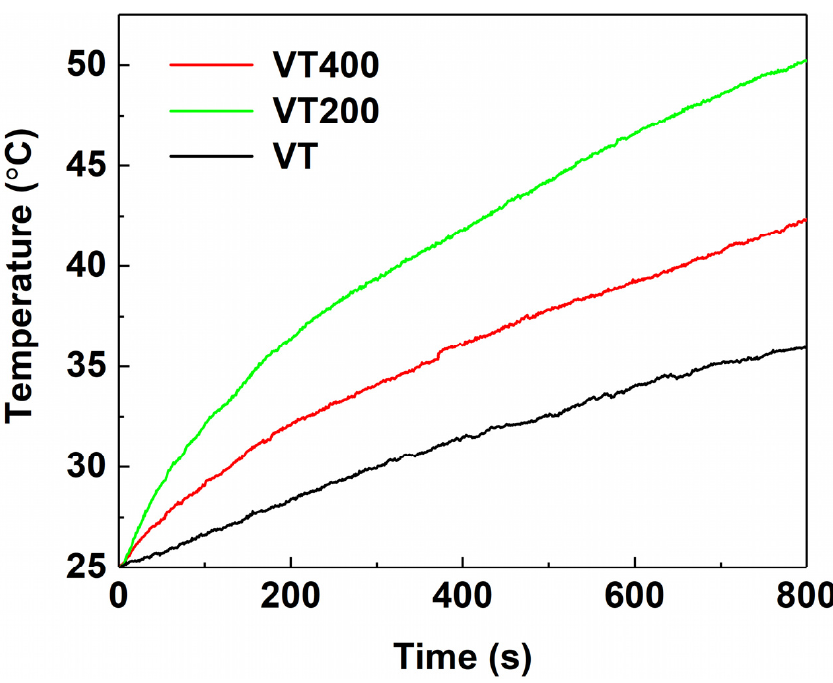
Figure 6. Heating curves of VT, VT200, and VT400 coatings in PBS state at 0.5 W/cm 2 .